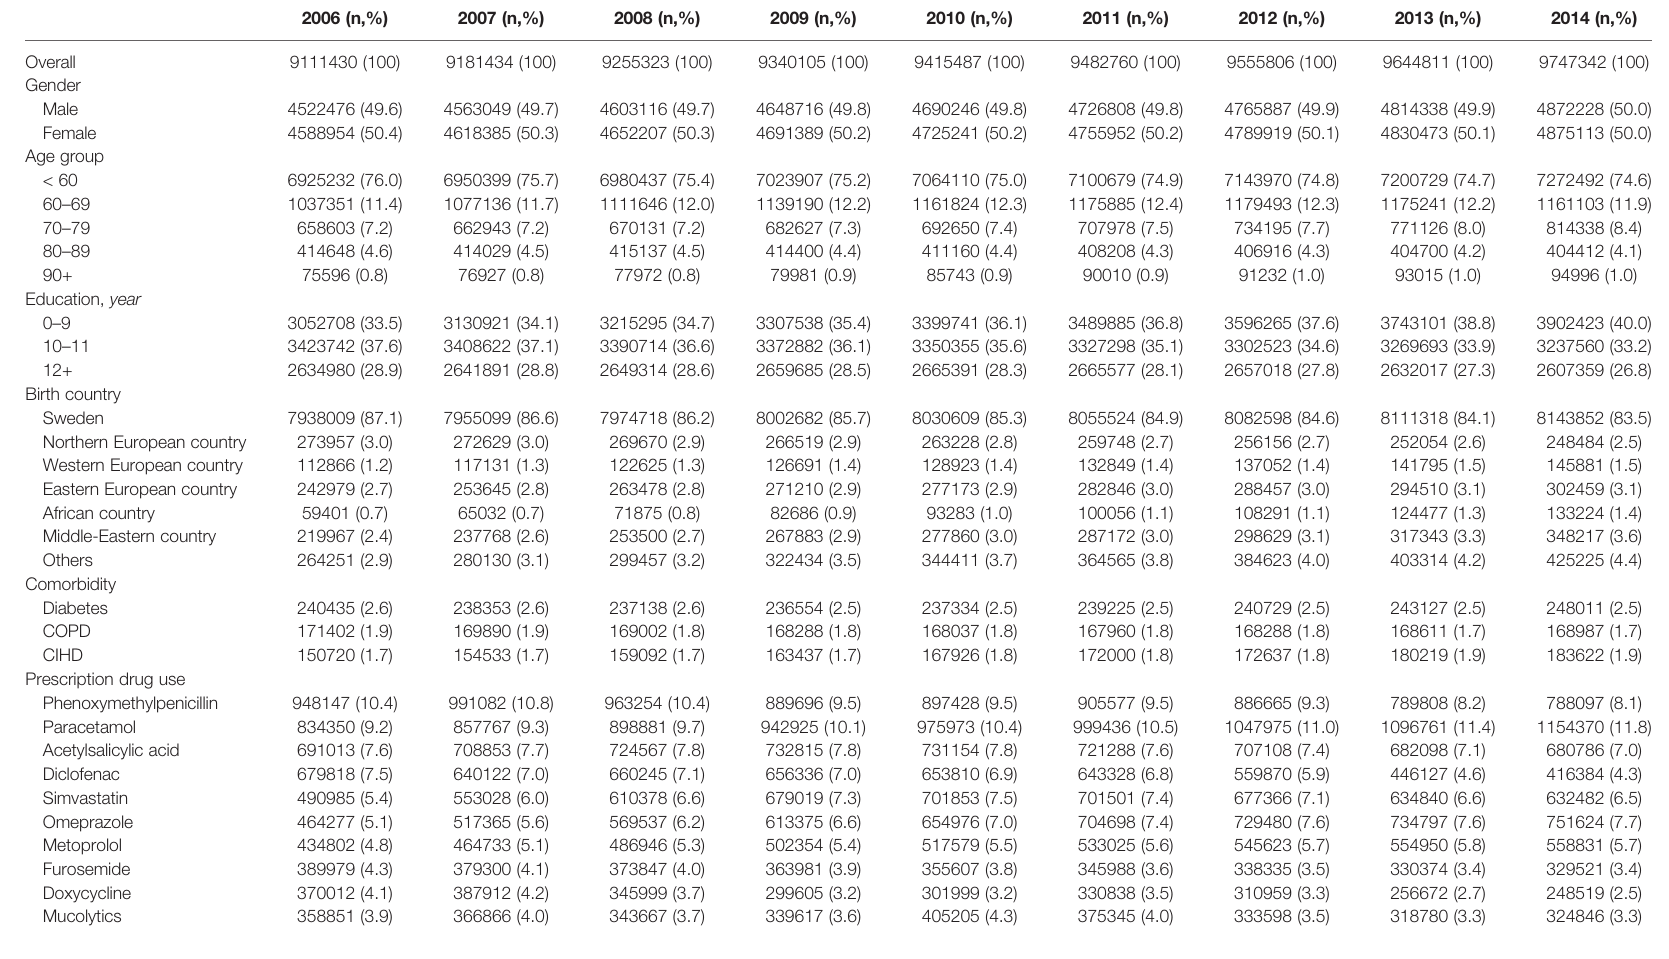
TABLE 1 | Demographic and clinical characteristics of Swedish population from 2006 to